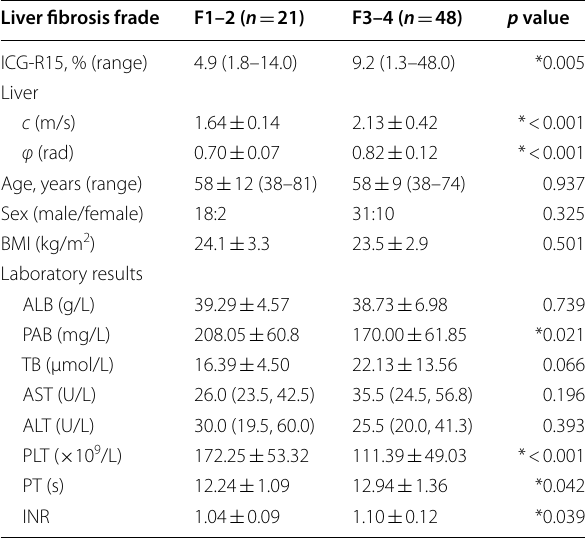
Table 3 ICG-R15 and tomoelastography indexes between patients with different liver fibrosis grades